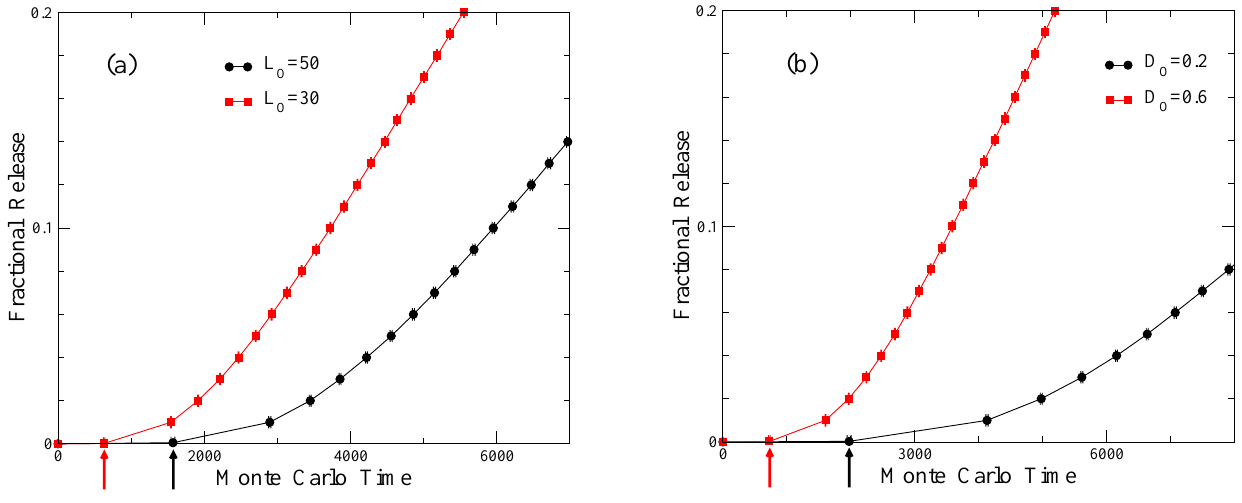
Figure 3. Effects of the outer layer characteristics on lag time. The initial part of release profiles is shown for ( a ) two slabs with fixed D O = 0.4 and different outer layer thicknesses L O = 30 (red squares) and L O = 50 (black circles) and ( b ) two slabs with fixed L O = 40 and different drug diffusion coefficients D O = 0.6 (red squares) and D O = 0.2 (black circles). Total slab thickness is L = 60 in all cases, while L x = L y = 20 and C 0 = 0.5 . Arrows in the x-axes indicate the corresponding lag times. Error bars in the x-axis represent mean-value errors through 100 different Monte Carlo realizations. Lines are guides to the eye.